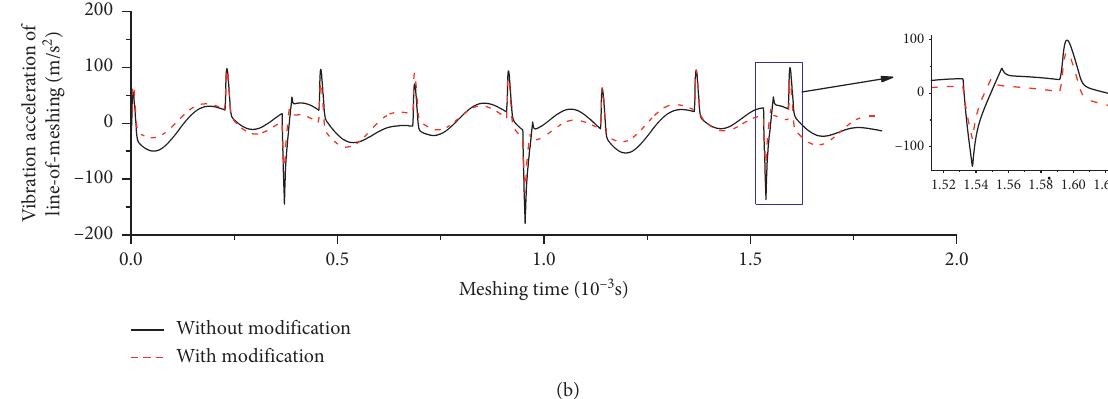
Figure 29: System vibration time domain at 12,000rpm with the modification of the output-stage pinion: (a) time-domain diagram of input-stage gear pair and (b) time-domain diagram of output-stage gear pair.